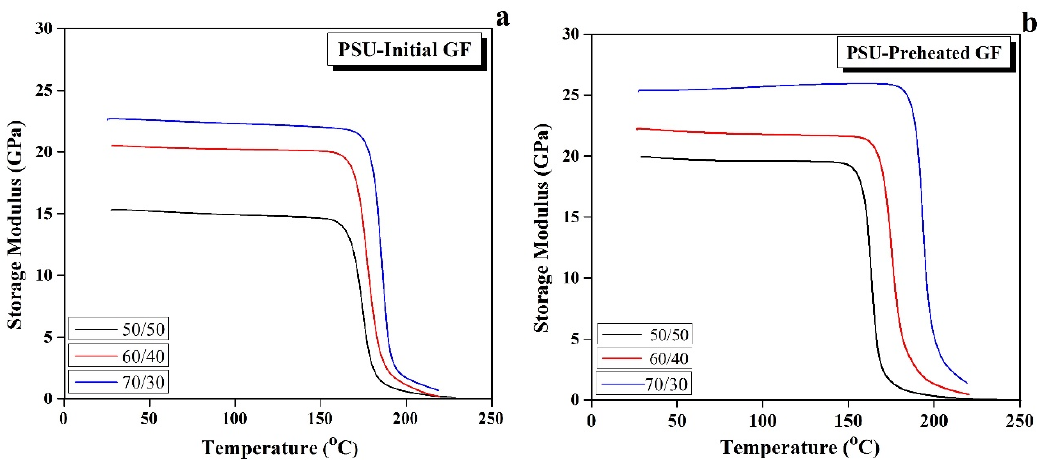
Figure 5. Temperature dependences of the storage modulus for the initial ( a , b ) the preheated GF reinforced